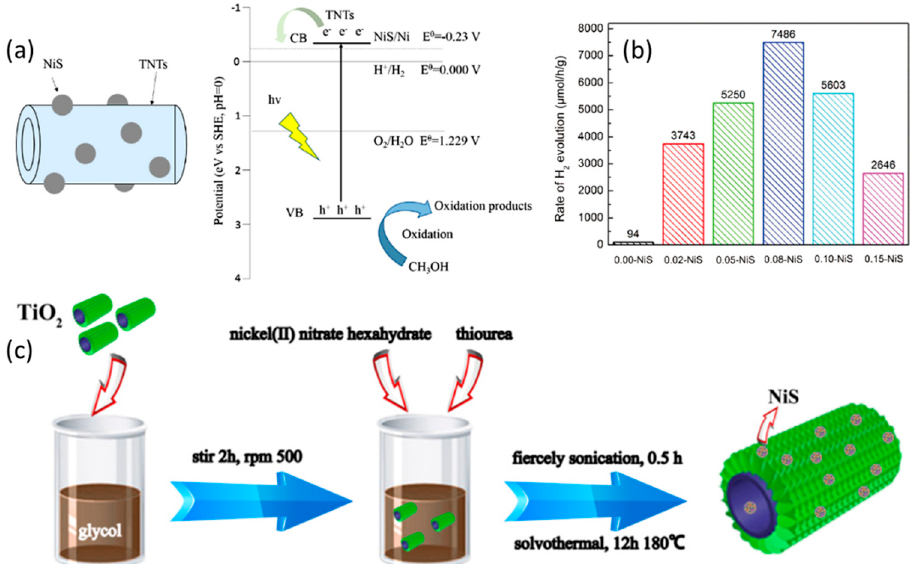
Figure 5. ( a ) Proposed charge transfer in NiS / TiO 2 nanotubes (TNTs) photocatalyst under UV irradiation; ( b ) average hydrogen production of TNTs with different amounts of NiS. Adapted with permission from [28]; ( c ) schematic illustration of synthesis of the NiS nanoparticles modified black TiO 2 hollow nanostructure (NBTNs). Adapted with permission from [29].